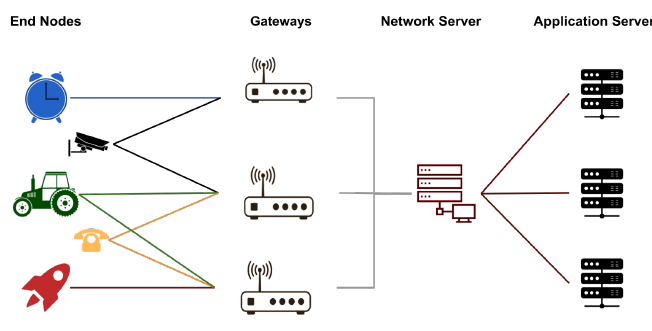
Figure 1. Topology of a LoRa network